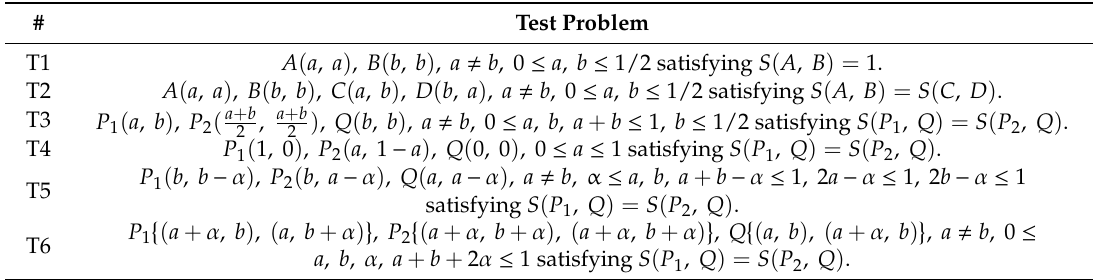
Table 2. The six general counterintuitive test